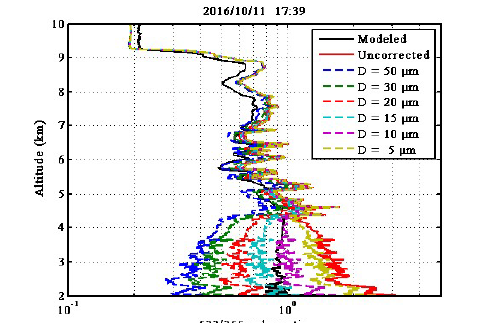
Fig3.: Ratio of the 532 to 355 nm in a mid-level altostratus (below 4.5 km) and calculation using the forward scattering model.